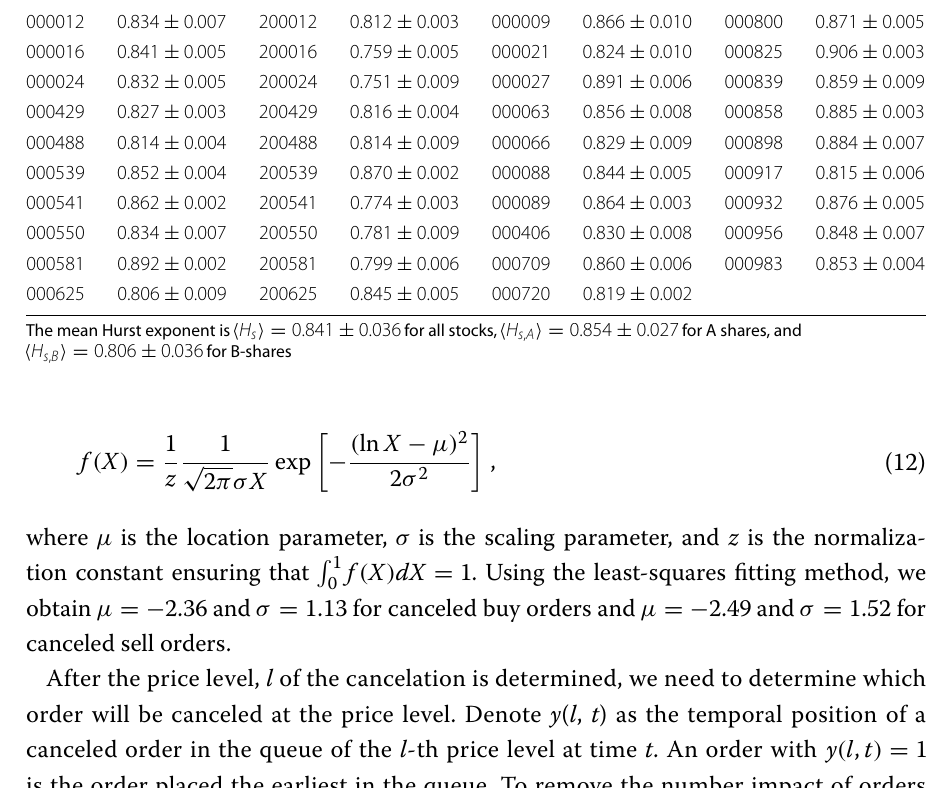
Table 1 Hurst exponents H s of order directions for the 32 A‑share stocks and 11 B‑share stocks estimated using the detrending moving average (DMA) method